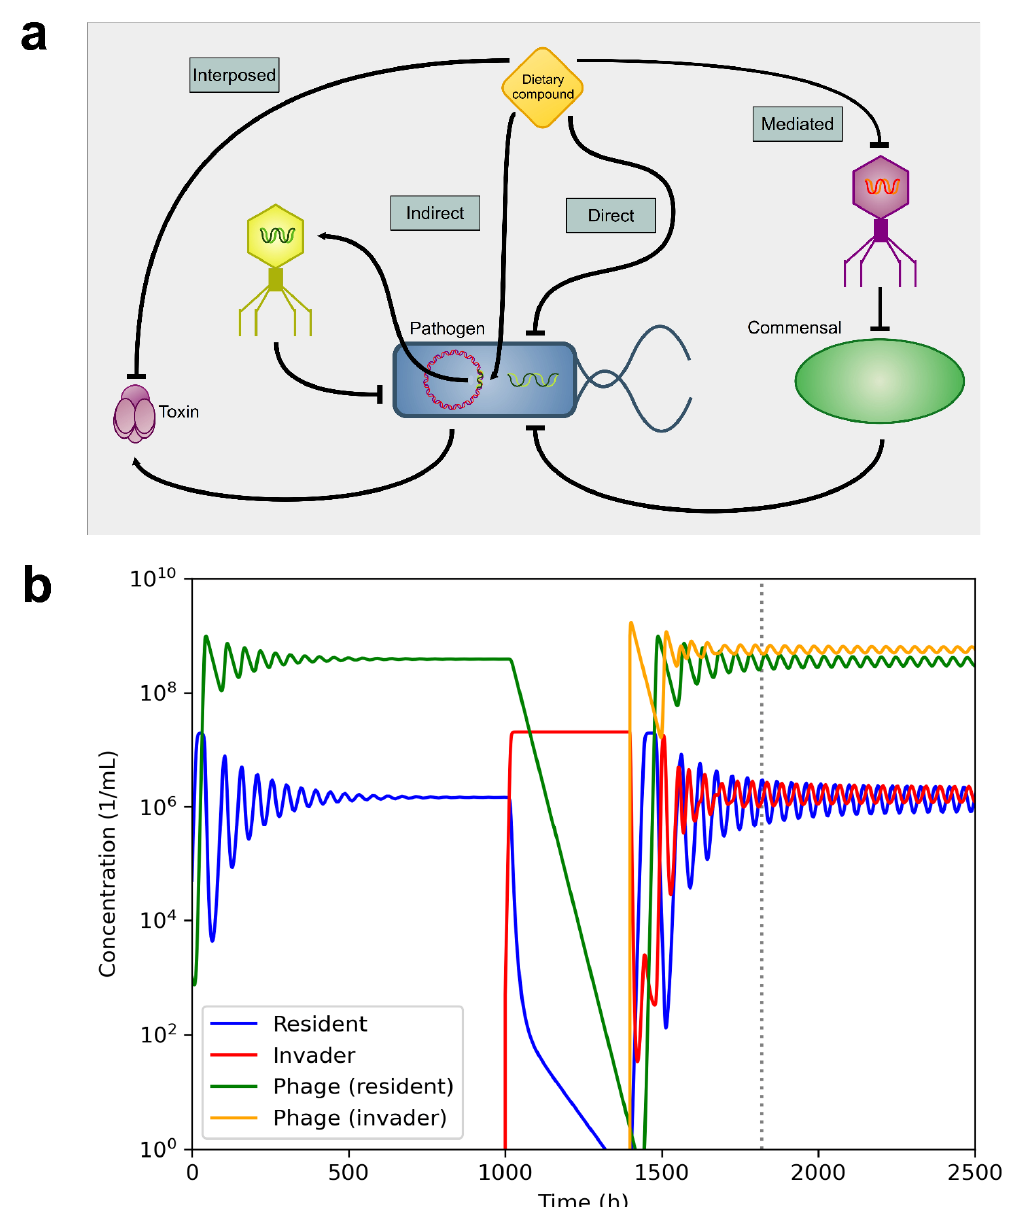
Figure 6. Overall impact of dietary compounds on infections. Dietary compounds can modify the bacterial population indirectly, based on the interaction between phages and bacteria, and by bacterial competition. ( a ) A dietary compound (nutrient) can interfere with the activity of a pathogenic bacterium at different levels by: inactivating a bacterial toxin (interposed inhibition); inducing a prophage already present in the invading bacterium, which then lyses the pathogen (indirect inhibition); acting bactericidal on invading species (direct inhibition); inactivating a lytic phage of an antagonist commensal species that, freed from the phagial burden, can compete with the pathogen (mediated inhibition). ( b ) Simulation of the interaction between bacteria and phages. The model considers the presence of a commensal bacterium (resident) and its phage. These reach an equilibrium where the number of cells or phages remains constant. A pathogenic bacterium (invader) will have virulence factors that favor its replication. As a result, it overgrows the commensal species. The activation of phages, namely through dietary-mediated induction of prophages, reduces the replication rate of the invader and re-establish, as a result, the commensal population. For the simulation, the parameters used were as follows. Carrying capacity: 2.2 × 10 7 . Maximum growth rate, 0.47 (commensal), and 0.72 (invader). Phage adsorption rate: 10 –9 , Phage lyse rate: 1.0. Phage burst size: 50. Particle loss rate: 0.05. Initial population of commensal bacteria: 50 000 cells. Amount of invader bacteria inoculated: 500 cells. Amount of phages: 1000 particles each. The model was implemented in Julia language using the DifferentialEquations